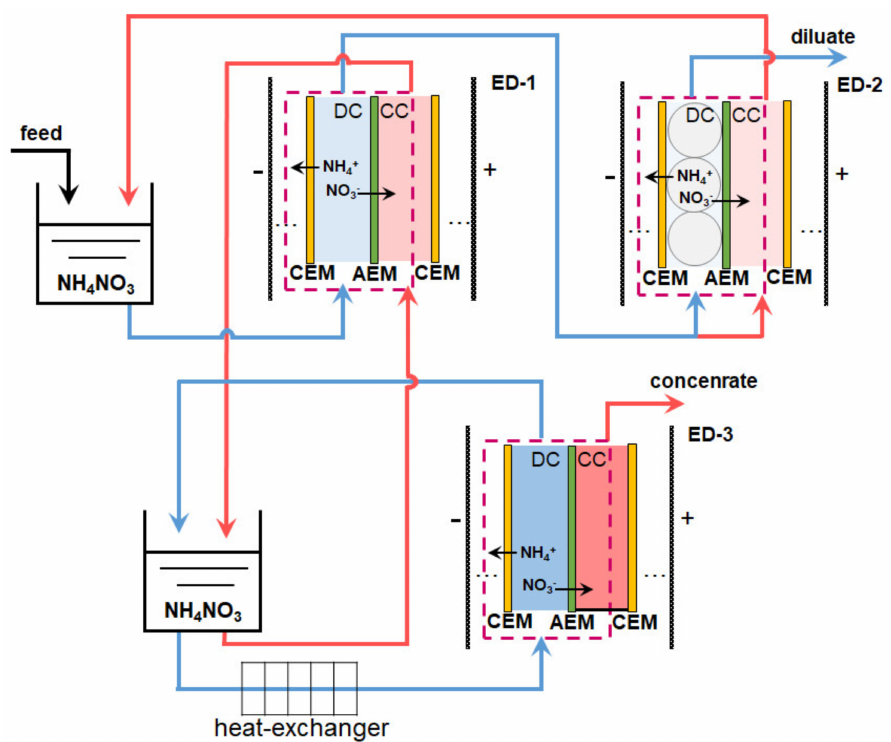
Figure 10. Scheme of ED processing of the condensate of the secondary stream formed during the production of ammonium nitrate. ED-1 is a conventional electrodialyzer, ED-2 is an electrodialyzer- deionizer with a mixture of anion-exchange and cation-exchange resins in desalination compartments, and ED-3 is an electrodialyzer-concentrator with enclosed (non-flow) concentration compartments. Based on